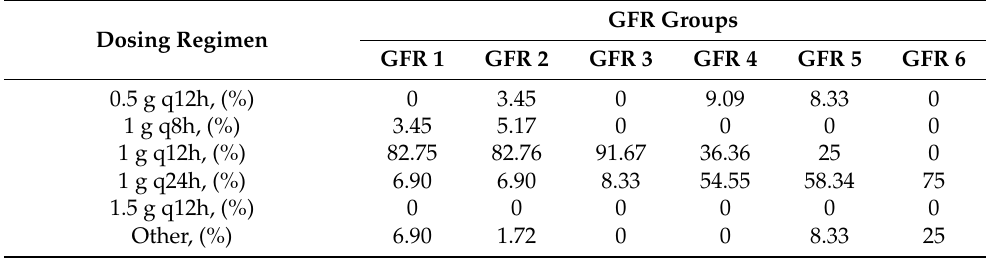
Table 3. Dosing regimen of vancomycin until the first TDM based on GFR in the hospital without a TDM protocol.